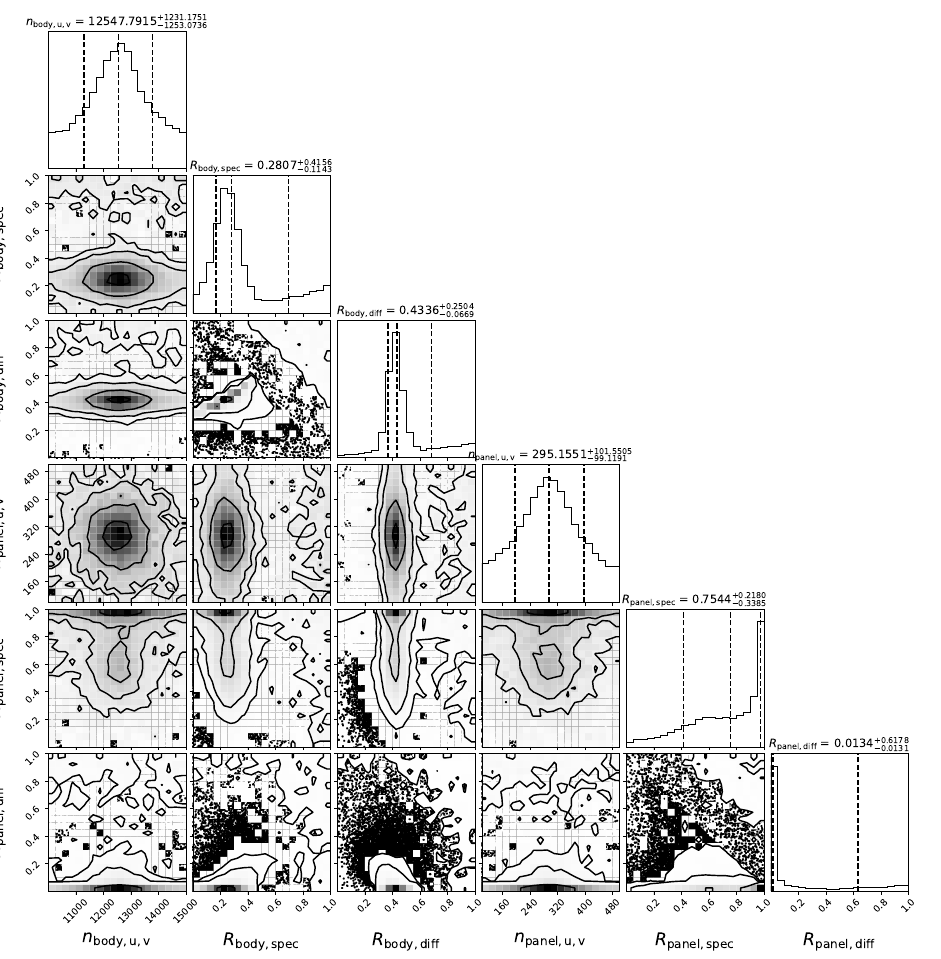
Figure 12. The parameter distributions of Object 2. We obtained the best-fitted results of surface material parameters by comparing the observed light curves with the synthetic light curves, as shown in Table 3. The results of optimal parameters were put into the simulation model. We divided the overall brightness of each object into the brightness of the body and the solar panels. The contrast diagram of the light curves are shown in Figures 13 and 14. The light curves shown in Figure 13 are slightly different at the peak position. The synthetic light curve changes more gently than the observed one. The simulation model used in this paper did not consider the occlusion between components, which may be the cause of this difference. From Figure 13, it can be seen that for Object 1, the overall brightness change is caused by the brightness change of the solar panels, while the brightness change of the body is so small that it is ignored. For Object 2, the brightness of the body determines the overall brightness, and the contribution of the solar panels is small and covered (see Figure 14). Therefore, for Object 1, we could think that only the material of the solar panels is relatively accurate, and the material of the body could not be determined. On the contrary, for Object 2, we could confirm the material of the body, but we could not infer the material of the solar